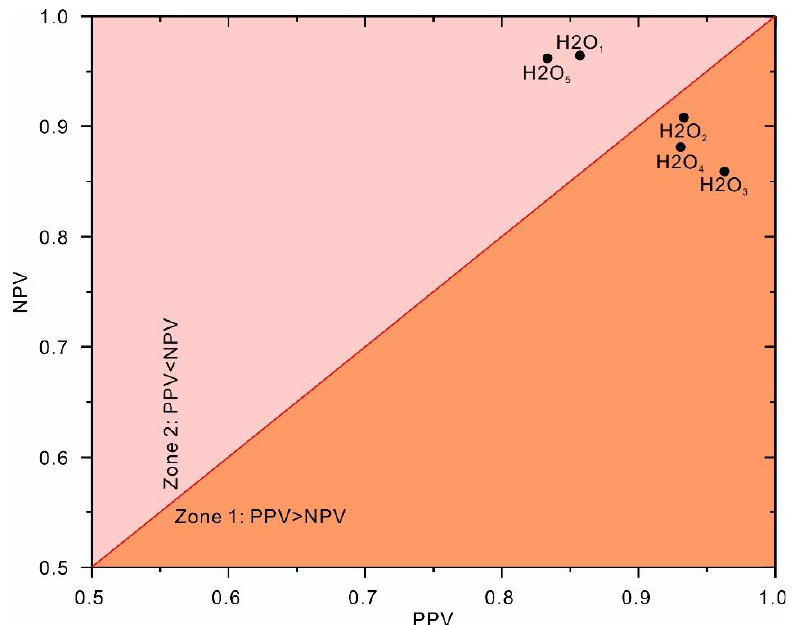
Figure 9. Correlation between the NPV and PPV values of the classification models based on the testing dataset.